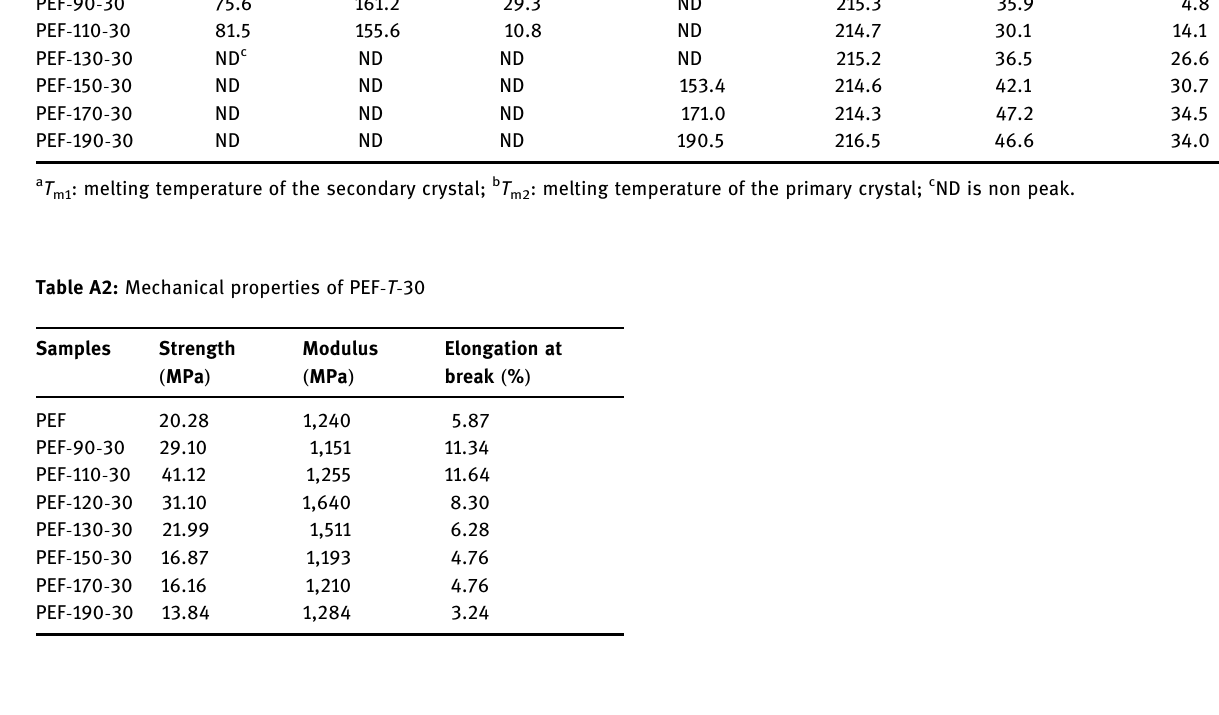
Table A3: Thermal properties of PEF - 110 - t Samples